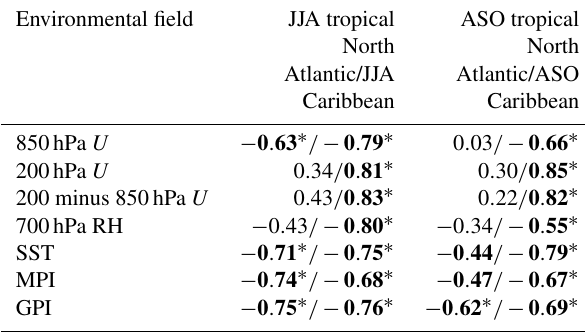
Figure 7. Formation locations of Atlantic named storms during the three seasons with (a) the highest Caribbean JJA DAOD (2014, 2015, and 2018) and (b) the lowest Caribbean JJA DAOD (2005, 2011, and 2017). Also displayed is the maximum intensity that each TC reached.